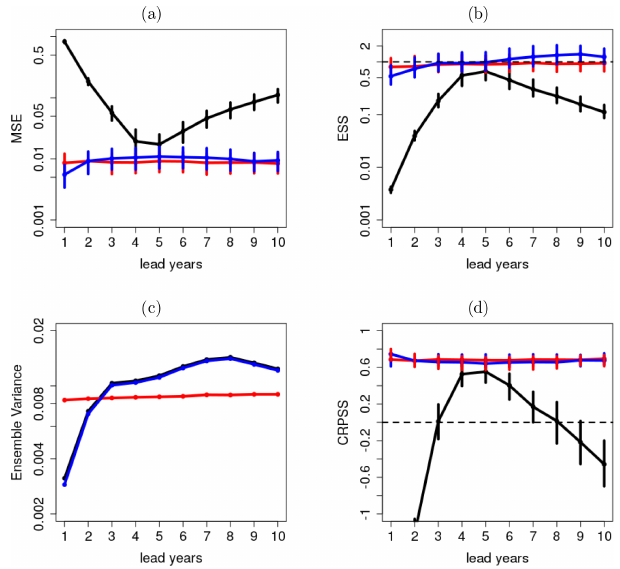
Figure 11. (a) MSE, (b) reliability, (c) ensemble variance and (d) CRPSS of global mean surface temperature without any correc- tion (black line), after recalibration with DeFoReSt (blue line) and boosted recalibration (red line). The CRPSS for the raw forecasts (black line) for lead year 1 is smaller than − 1 and therefore not shown. The vertical bars show the 95% confidence interval due to 1000-wise